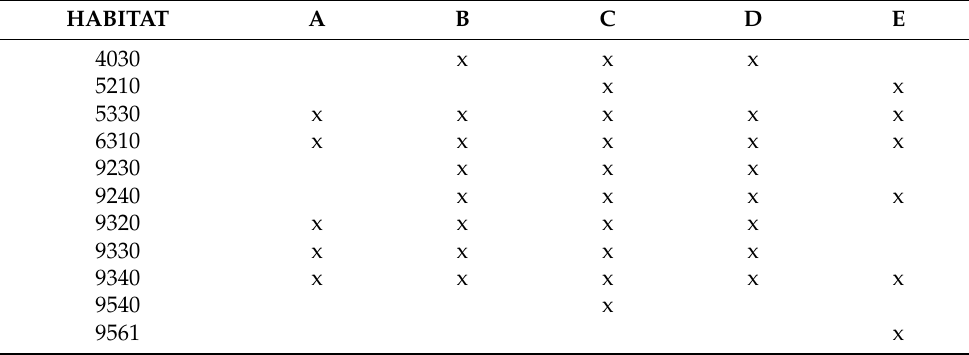
Table 1. Presence of the different habitats in each SCI (A, B, C, D, E). A= SCI Almaden, Chillon and Guadalmez, B= SCI Sierra the Canalizos, C= SCI Sierra Morena, D= SCI Rivers of the middle Guadiana basin and slopes, E= SCI Lagunas de